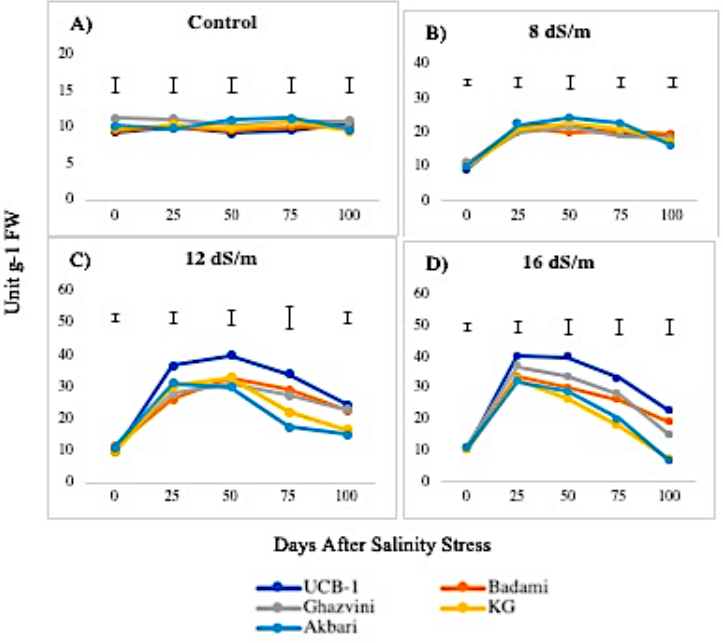
Figure 7. E ff ect of NaCl-mediated stress on APX activity in pistachio Figure 7. Effect of NaCl-mediated stress on APX activity in pistachio leaf. Figure 7. Effect of NaCl-mediated stress on APX activity in pistachio leaf.